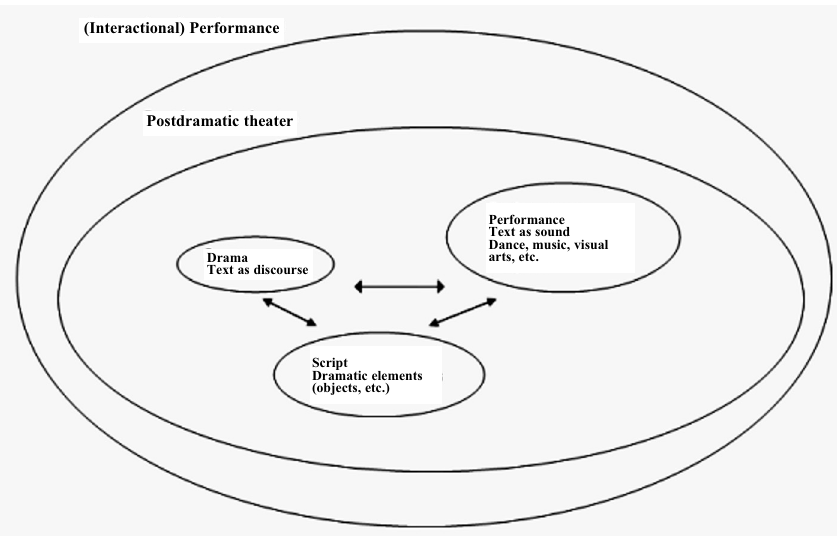
Fig. 3. Drama, script, theater, performance in postdramatic